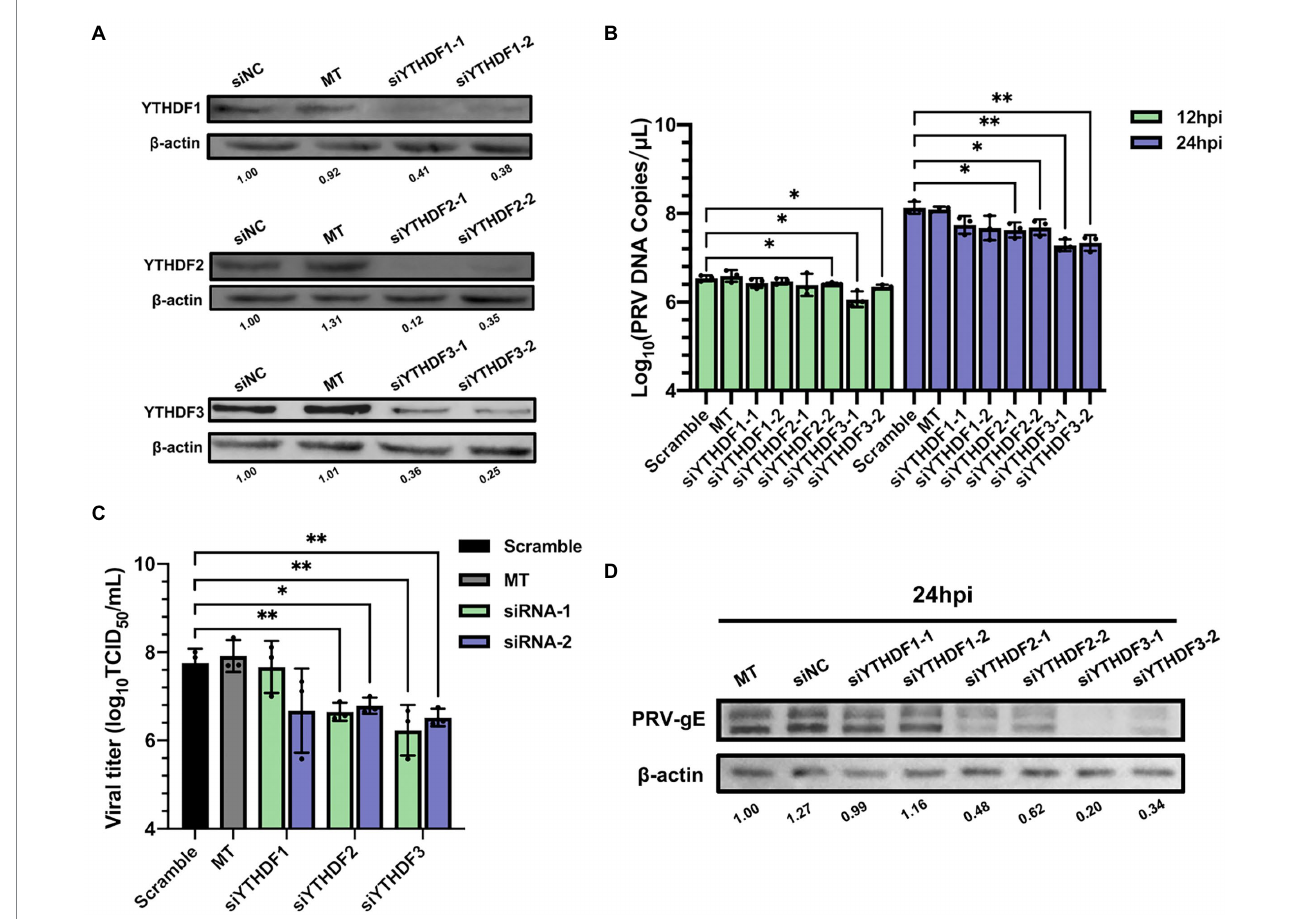
FIGURE 7 Specific recognition protein YTHDF2 and YTHDF3 inhibited PRV proliferation. (A) PK15 cells were transfected with the specified siRNAs (60 nM) for 24 h. YTHDF1, YTHDF2 and YTHDF3 were assessed by immunoblotting analysis. β -actin was used as a loading control. (B) PK15 cells were transfected with the specified siRNAs and were mock transfected (MT) with transfection reagent alone for 24 h. PK15 cells were infected with PRV-FJ01 (MOI = 0.1) for 12 and 24 h. PRV DNA copies were evaluated by RT-qPCR analysis. (C) PK15 cells were transfected with the indicated siRNAs and were mock transfected (MT) with transfection reagent alone for 24 h. PK15 cells were infected with PRV-FJ01 (MOI = 0.1) for 24 h. PRV titers were assessed by TCID 50 analysis. (D) PK15 cells were transfected with the specified siRNAs and were mock transfected (MT) with transfection reagent alone for 24 h. PK15 cells were infected with PRV- FJ01 (MOI = 0.1) for 24 h. PRV gE was assessed by immunoblotting analysis. β -actin was used as a loading control. * p < 0.05, ** p <